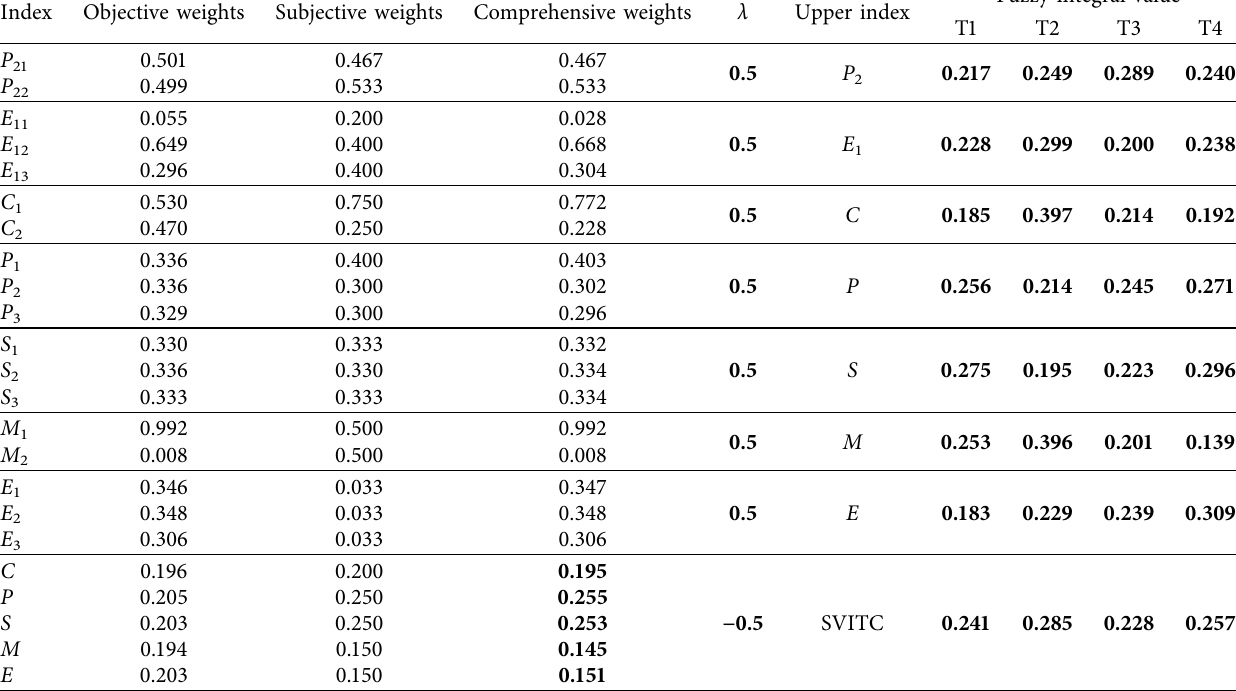
Table 6: Comparison of SVITC of the four